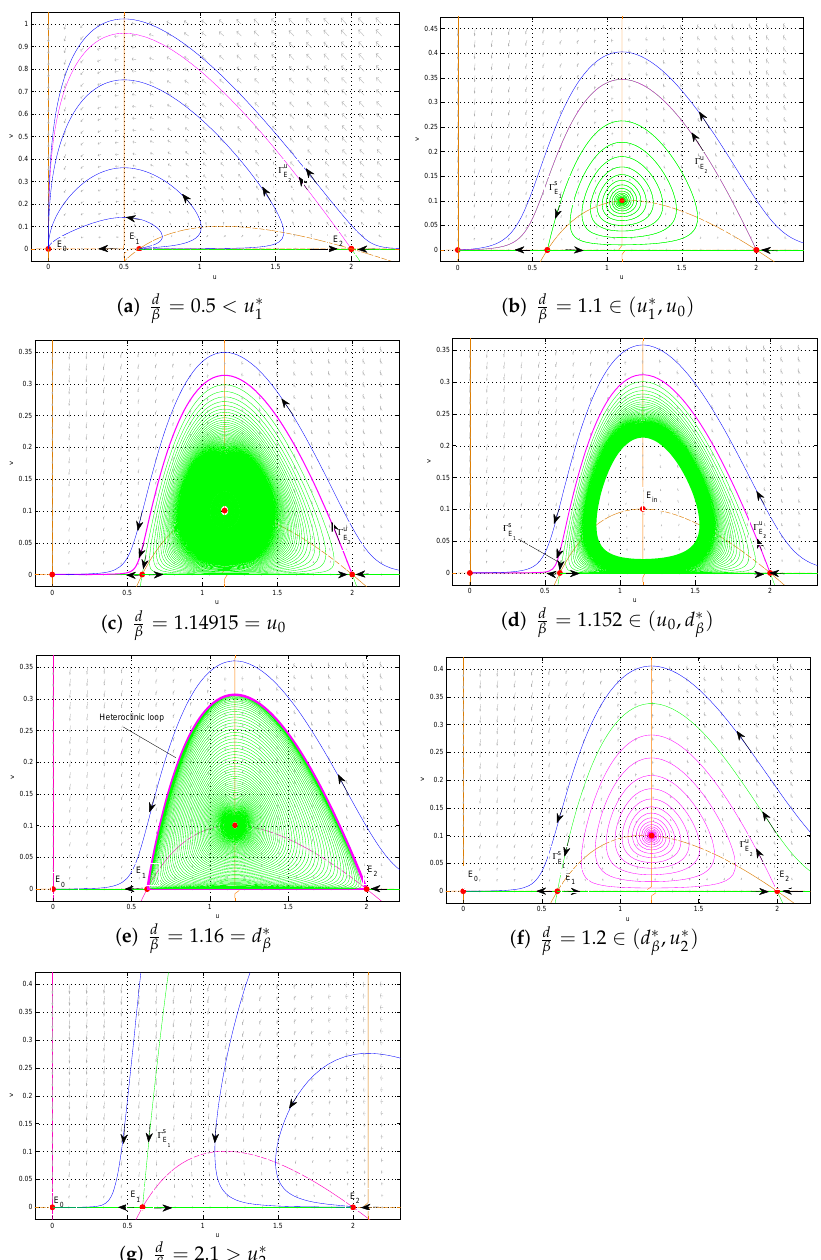
Figure 3. The dynamic behaviors of model (2) in the strong Allee effect case as d = 2 ( a = 2, r = 1 ) . The heteroclinic bifurcation point Here, parameters K = 3, m = 2.5, α = 1, a r = 1.14915. u ∗ = 0.6, u = 1.14915, u ∗ = d ∗ 0 2 1 β